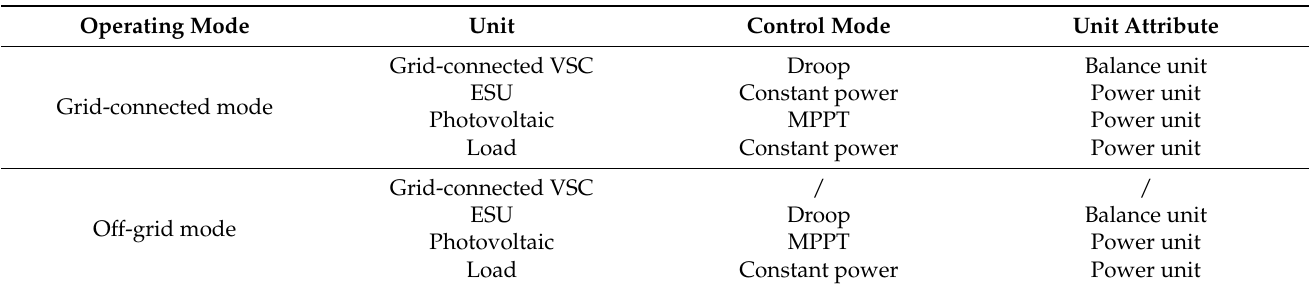
Figure 1. Topological structure of DC microgrid system. Table 1. Operating status of each unit of DC